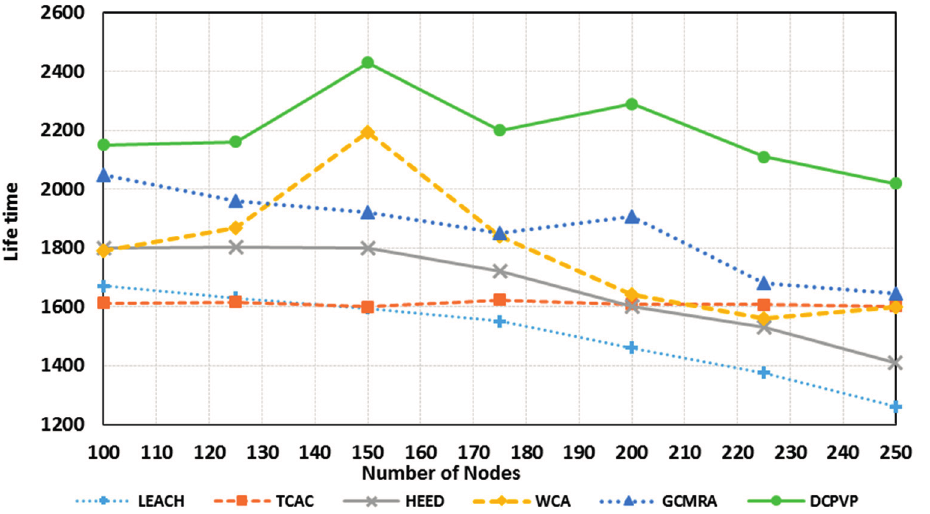
Figure 17. Comparison of lifetime in random